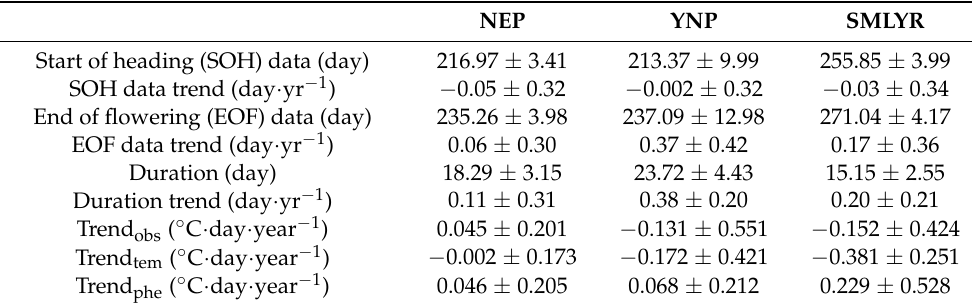
Table 3. Statistics of the average phenological dates and their trend during 1992–2013. Values are shown as mean ± standard